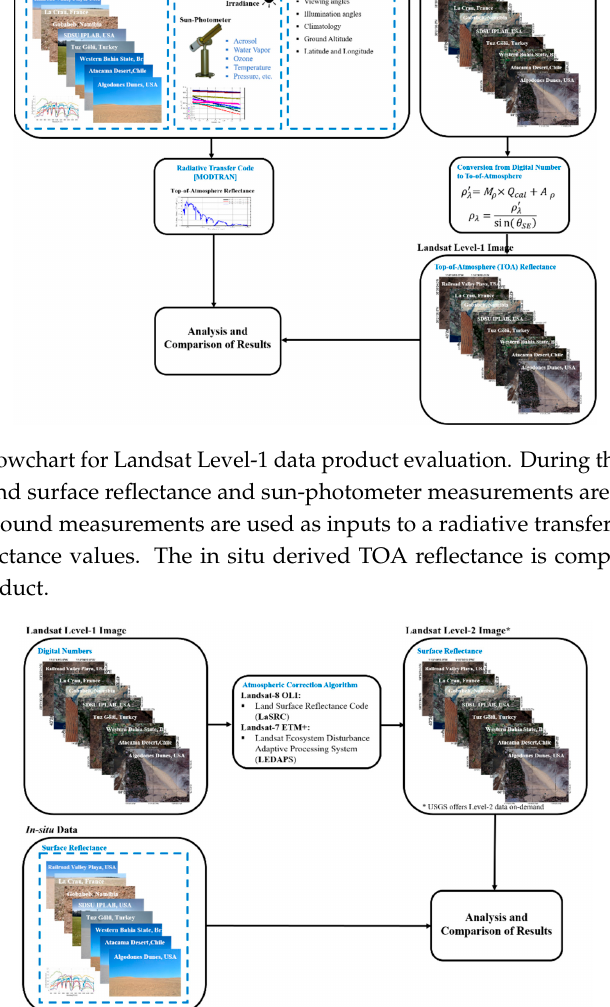
Figure 10. General flowchart for Landsat Level-2 data product evaluation. Landsat-8 Operational Land Imager (OLI) and Landsat-7 Enhanced Thematic Mapper Plus (ETM+) Level-2 surface reflectance data products are generated from the Level 1 products using, respectively, the Land Surface Reflectance Code (LaSRC) and Landsat Ecosystem Disturbance Adaptive Processing System (LEDAPS) algorithms. During the Landsat overpass, hyperspectral ground surface reflectance measurements are acquired. The in situ measured surface reflectance is then compared to the Level-2 surface reflectance data product.